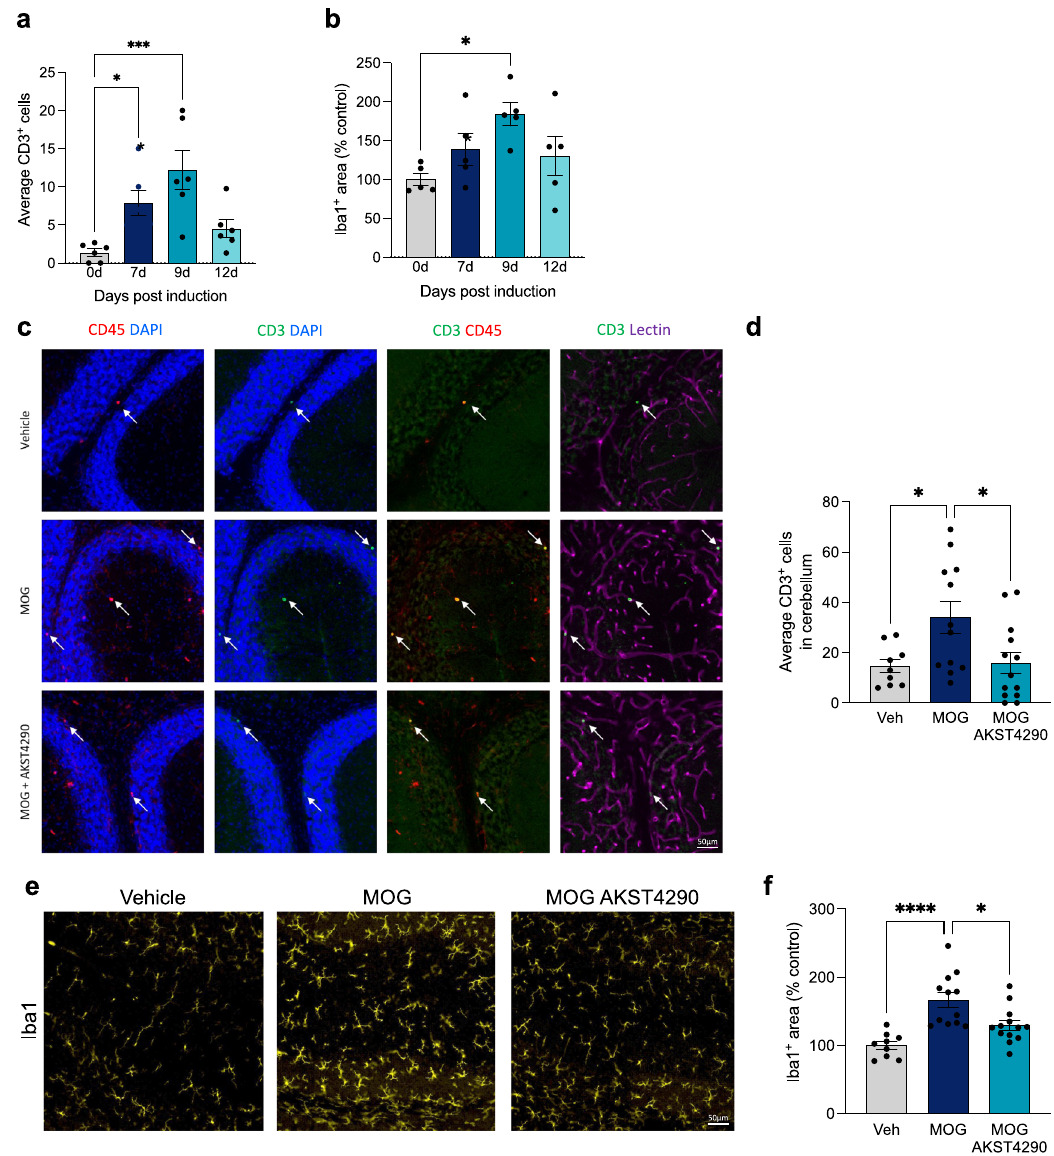
Fig. 5 CCR3 inhibition reduces in fi ltration of T cells into the brain in a model of induced autoimmune in fl ammatory disease. a Quanti fi cation of average CD3 + T cells in the cerebellum of 2-month-old mice at 0, 7, 9, and 12-days following myelin oligodendrocyte glycoprotein 35 – 55 (MOG) induction ( n = 6). Data shown as average CD3 + T cell count across 4 sagittal cerebellum sections for each mouse (* p < 0.05, one-way ANOVA). b Relative Iba1 + signal in the cerebellum of 2-month-old mice at 0, 7, 9, and 12-days following MOG induction ( n = 5). Data shown as percent area of the region of interest (* p < 0.05, one-way ANOVA). c Representative images of CD3 + T cells co-stained with CD45 and vessel marker Lectin in the cerebellum. d Average number of CD3 + T cells in the cerebellum (* p < 0.05, one-way ANOVA; n = 9, 12, 13). e Representative images of Iba1 + microglia in the cerebellum. f Relative Iba1 + signal in MOG-injected mice with AKST4290 treatment (* p < 0.05, **** p < 0.0001; one-way ANOVA; n = 9, 12,13). All data shown are mean ± standard error of the